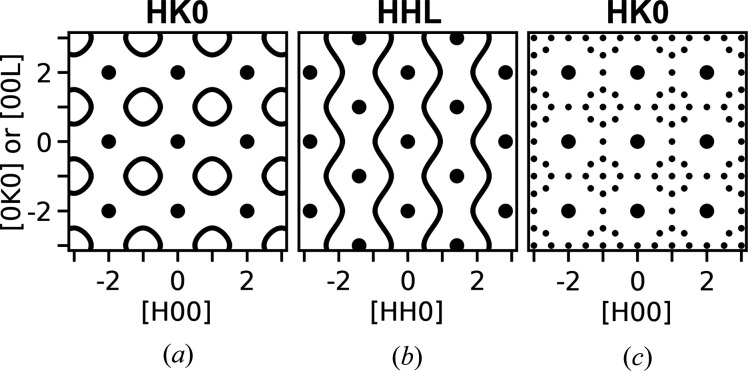
Sketches showing the scattering measured for a number of defective half-Heusler systems by Xia et al. (2019 ▸). (a), (b) Sketches that show the HK0 and HHL planes for short-range order systems Nb0.8CoSb, Ti0.9NiSb, V0.9CoSb and Nb0.8Co0.92Ni0.08Sb. (c) A sketch showing the HK0 plane for ordered Nb0.82CoSb and Nb0.84CoSb. Large dots indicate the reflections from the average structure, lines indicate diffuse scattering and small dots indicate weak additional peaks.